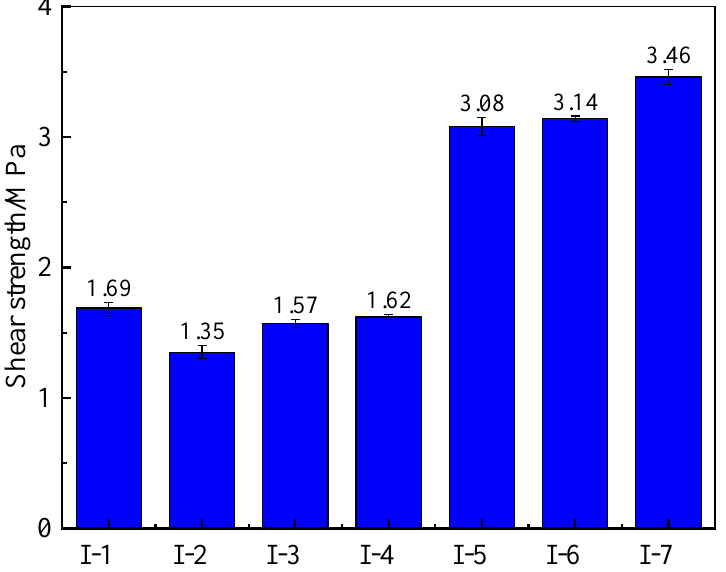
Figure 6. Shear strength of specimens without interlaminar treatment. The data of Figure 6 showed that the shear strengths between layers of asphalt mixture– asphalt mixture and PU mixture–asphalt mixture were less than 2 MPa, and the shear failure mostly occurred at the interlayer. The shear failure form of specimens was shown in Figure 7a–c. The shear strength of I-3 was 0.22 MPa greater than that of I-2, indicating that when the gradations of the upper and lower layers were similar, the interlayer shear strength was higher when the PU mixture used in the upper layer. The shear strength of specimen I-1 was greater than those of I-2, I-3, and I-4, indicating that the interlaminar shear strength between asphalt mixtures was larger than that between PU mixture and asphalt mixture. Therefore, the shear strengths of these structures with different interlaminar treatment schemes are analyzed in the next section. The interlayer bonding effect of PU mixtures, PU mixture, and cement-stabilized macadam were better than that of other structures. The interlayer shear strength was greater than 3 MPa, and until shear failure occurred, there was no obvious damage between the layers of these structures, and the interlayer was in a good condition. However, the upper and lower materials were damaged. The shear failure form of specimens without interlaminar treatment was shown in Figure 7d–f. The reason may be that the macro- molecular chain of the PU binder between the two layers of PU mixtures produced an interweaving effect, and the macromolecular chain segment of the PU binder between the PU mixture layer and the cement-stabilized macadam layer interacted with the inorganic materials; thus, the interlayer stability was good, and treatment was not required between the